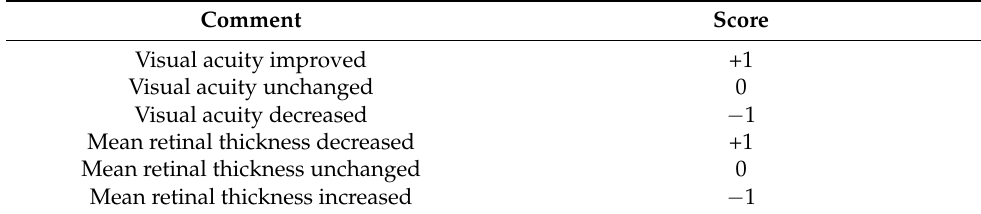
Table 1. Point system for the evaluation of treatment success.